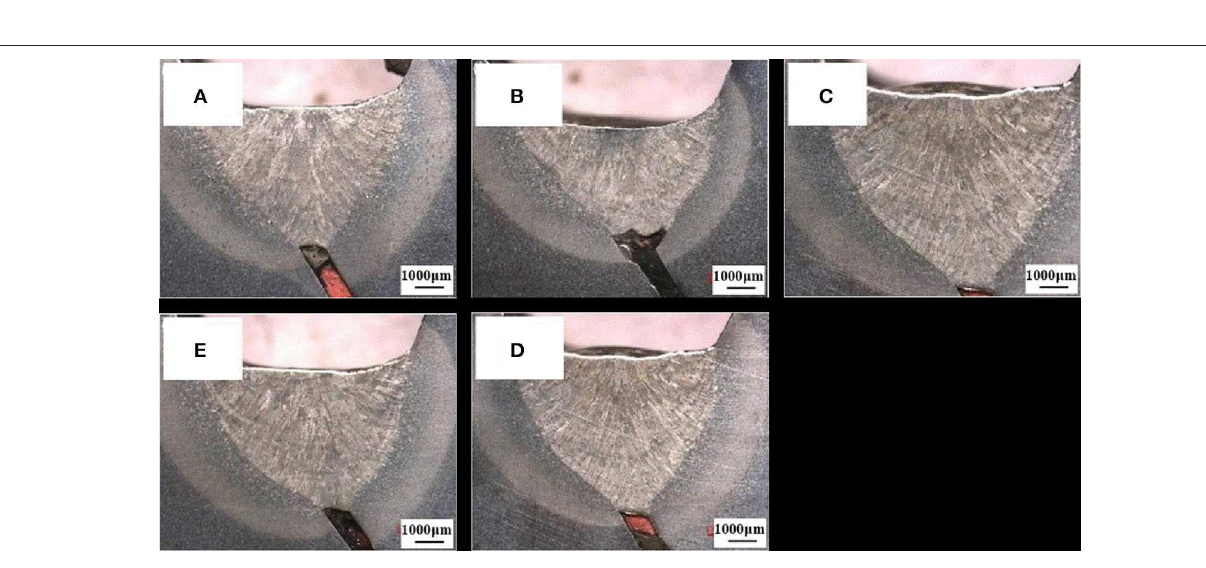
Frontiers in Materials | www.frontiersin.org